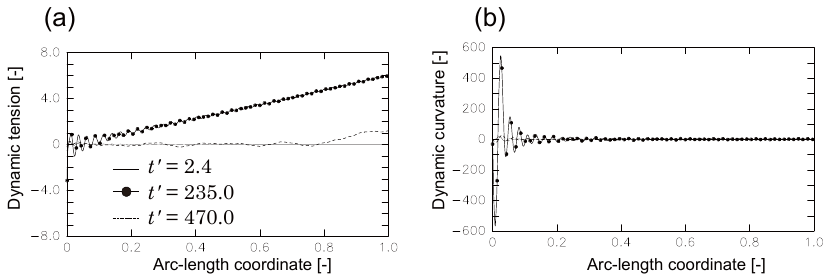
Figure 14. Distributions of the ( a ) tangential and ( b ) normal displacements for 250 buckets. t (cid:48) denotes dimensionless time.